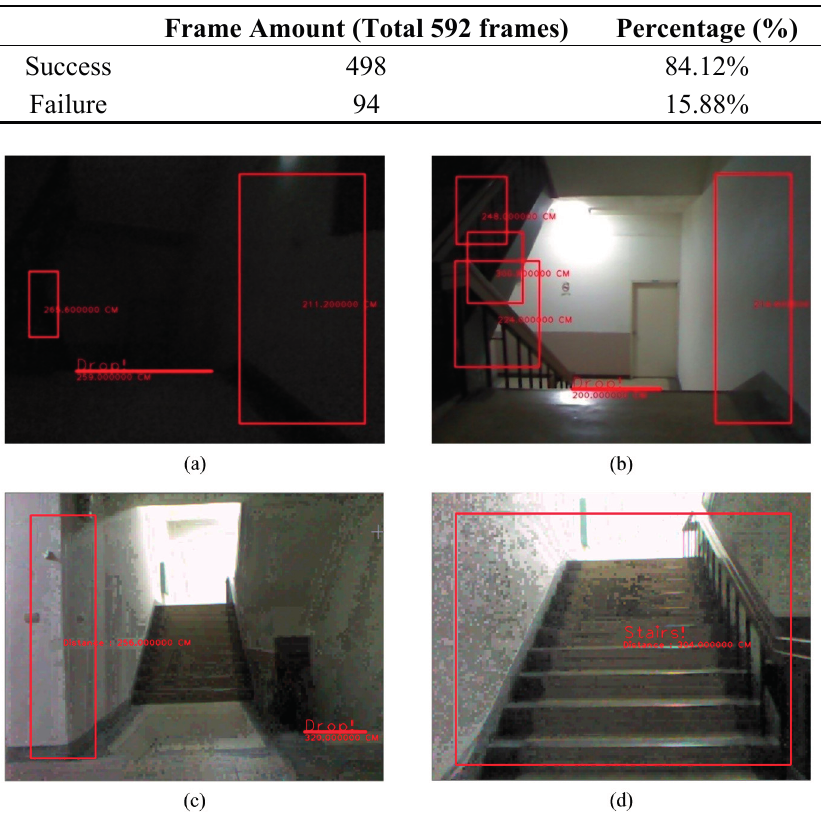
Figure 25. The detection of an obstacle indoors under insufficient light. ( a ) Descending stairs 1; ( b ) Descending stairs 2; ( c ) Rising stairs 1; ( d ) Rising stairs 2.